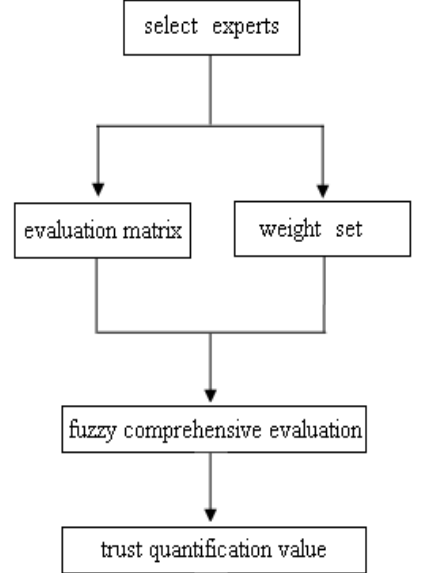
Fig. 2. Trust quantification algorithm